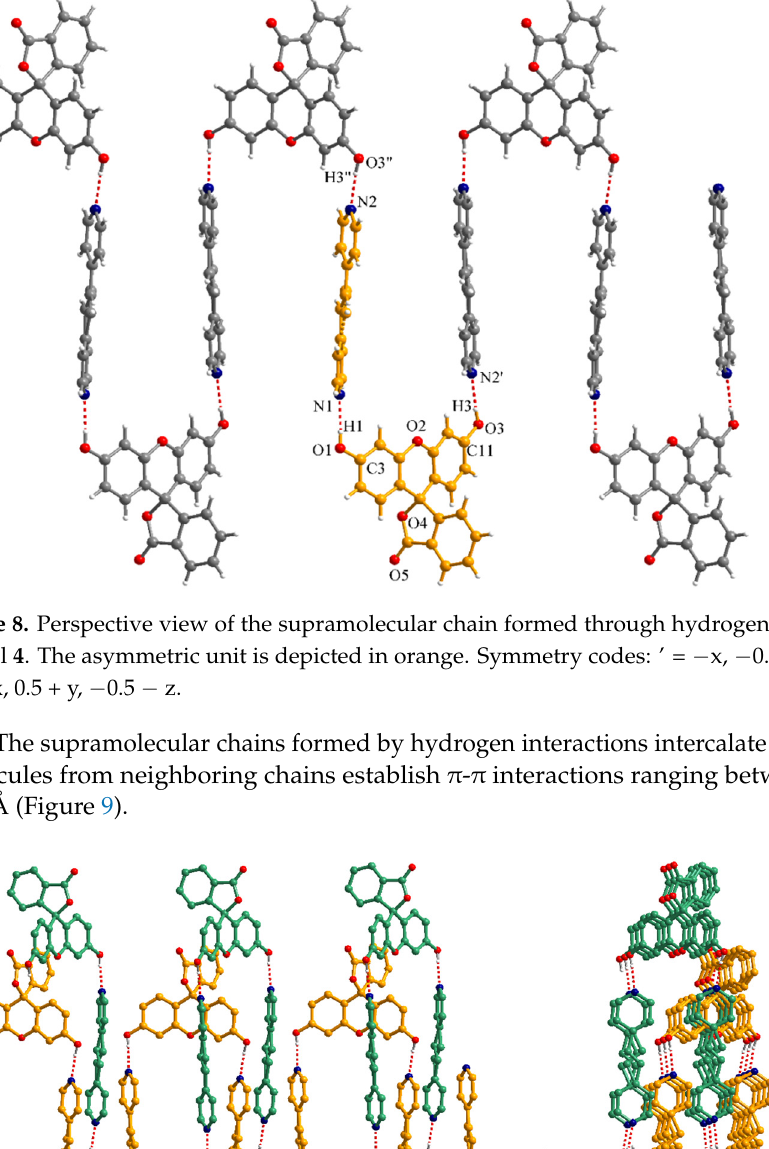
Figure 7. Perspective view of the 1D supramolecular array formed through hydrogen interactions in crystal 3 (the hydro- gen atoms not involved in hydrogen interactions were omitted for clarity). Symmetry code: “= − 1 + x, y, − 1 + z.